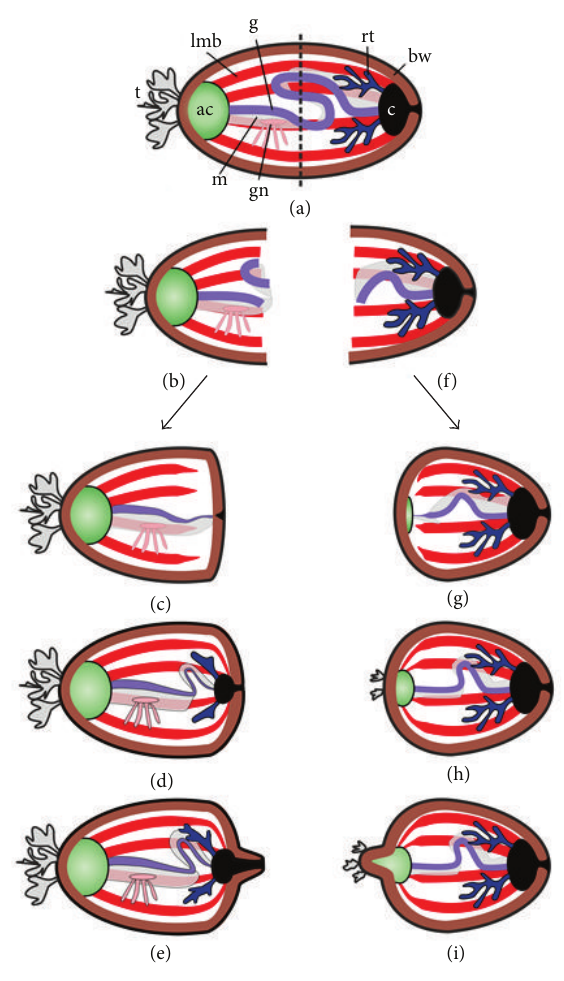
Figure 2: Scheme of regeneration of internal organs after fission in holothurians. (a) Animal before fission. (b) Anterior fragment just after fission. (c) Formation of gut and cloaca in anterior fragment. (d) Formation of respiratory trees in anterior fragment. (e) Growth of the posterior part of the body. (f) Posterior fragment just after fis- sion. (g) Formation of AC and gut rudiments in posterior fragment. (h) Posterior fragment with regenerated internal organs. (i) Growth of the anterior part of the body. ac: aquapharyngeal complex; bw: body wall; c: cloaca; g: gut; gn: gonad; lmb: longitudinal muscle band; m: mesentery; rt: respiratory tree; t: tentacles. Dotted line: site of division of the body during